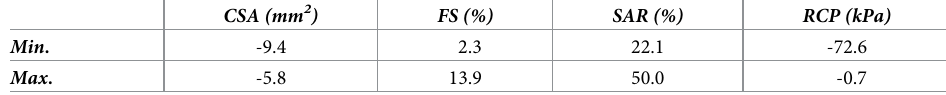
Table 6. Minimum and maximum values for each performance metric ( CSA , FS , SAR and RCP